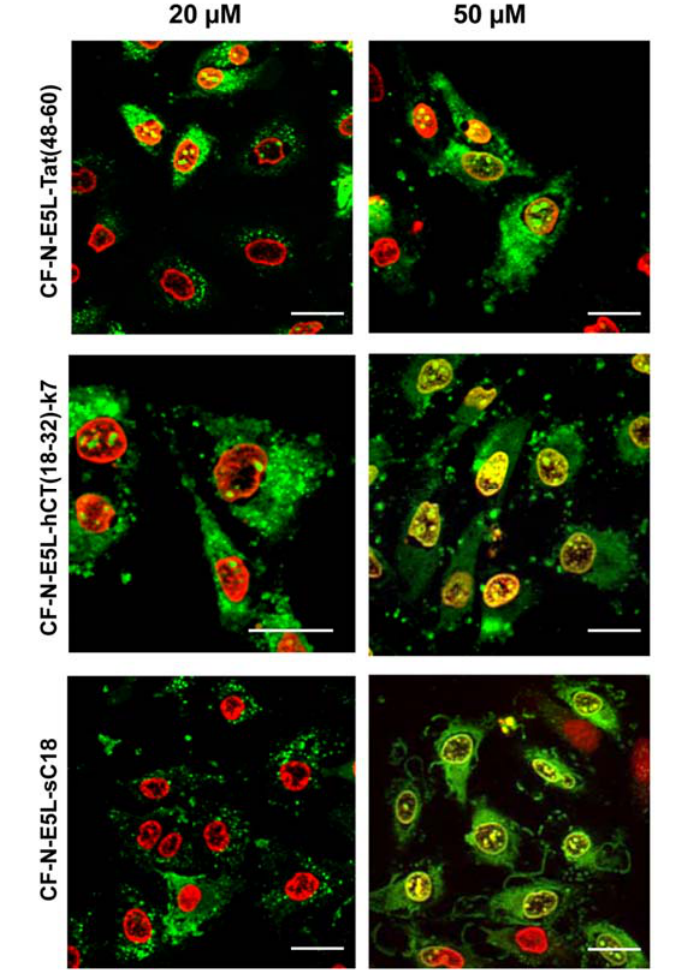
Figure 2. Cellular uptake of 20 µM and 50 µM CF-labelled chimeric N-E5L-CPP within 60 min in HeLa cells is shown. The cells were counter-stained with the nuclei marker benzimide H33342 that is illustrated in red for a clear display. External CF fluorescence was quenched with trypan blue solution. Scale bar is 20